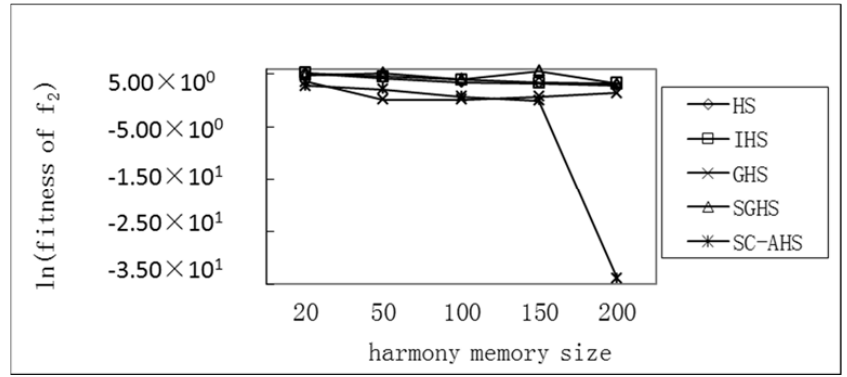
Figure 7. Comparison of the average optimum with different harmony memory sizes of the Sphere function.